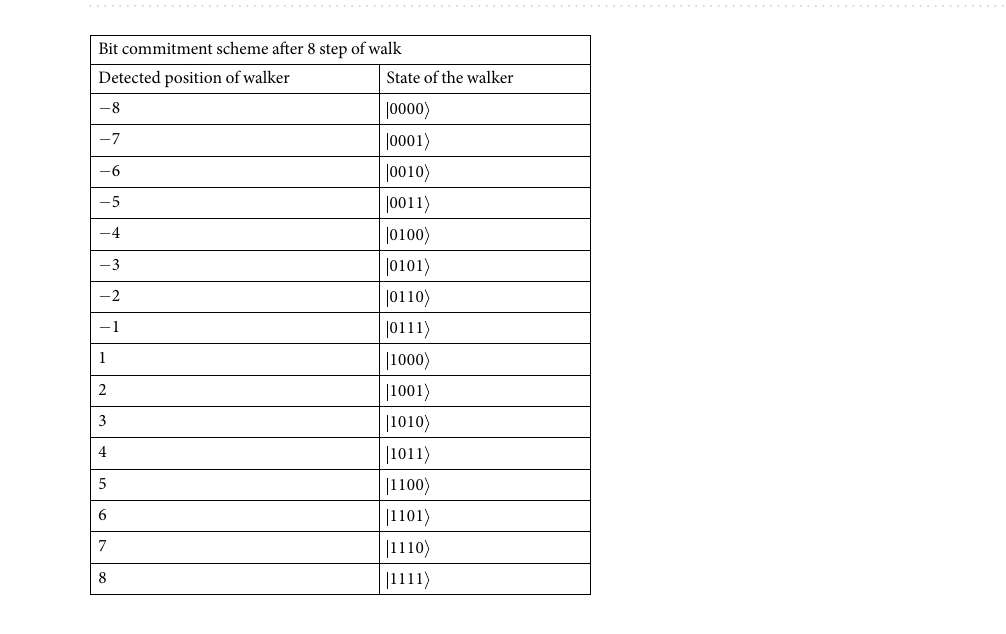
Figure 3. Schematic representation four bit random number generation from a single qubit after four step of SS-QW. If the state of the walker is also considered, we will effectively have five bit random number after